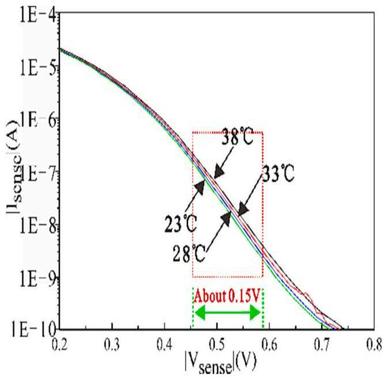
Subthreshold current - voltage curves of the pFET sensor for various settings of the wafer chuck T.